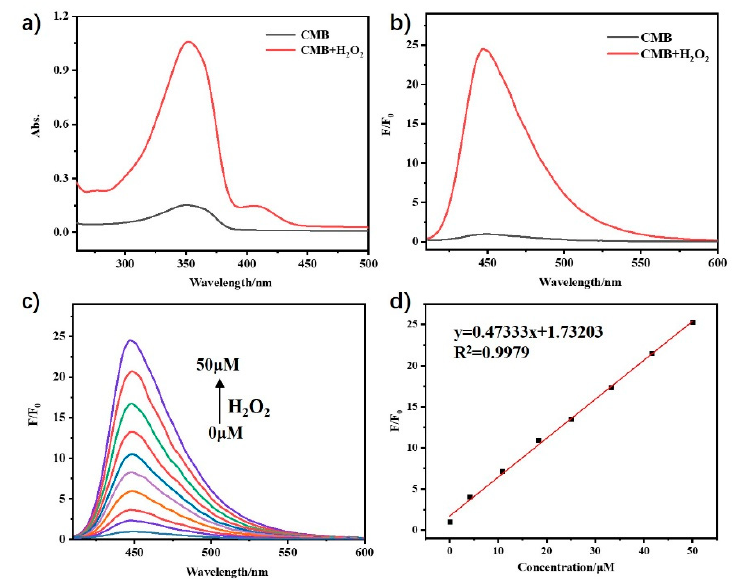
Figure 1. ( a ) UV-vis absorption and ( b ) fluorescence emission spectra of CMB before and after ad- addition of H 2 O 2 . ( c ) Fluorescence responses of CMB (2 µ M) to various concentrations of H 2 O 2 . dition of H 2 O 2 . ( c ) Fluorescence responses of CMB (2 μ M) to various concentrations of H 2 O 2 . ( d ) The ( d ) The linear correlation between the fluorescence intensity at 450 nm and H 2 O 2 linear correlation between the fluorescence intensity at 450 nm and H 2 O 2 concentration.